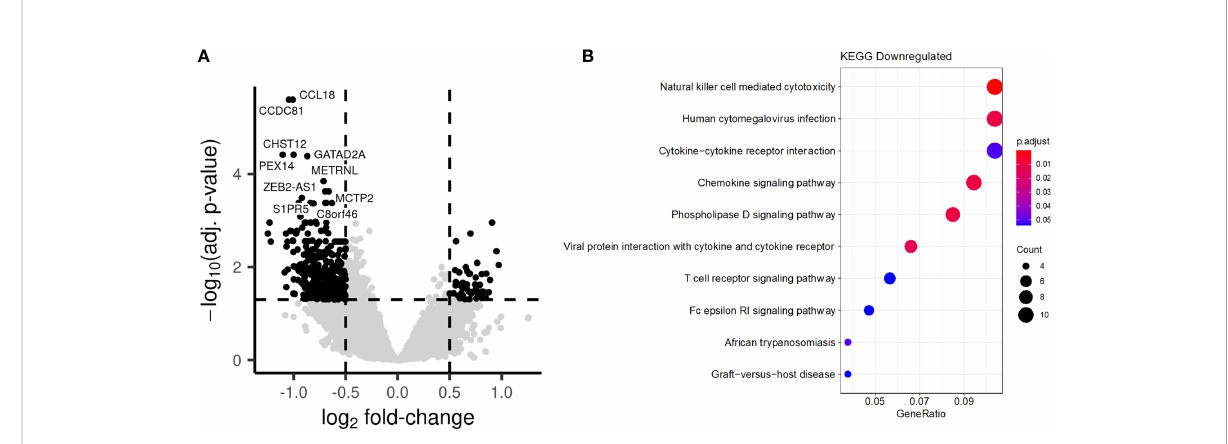
FIGURE 9 BCG vaccination induces long-term changes in chromatin accessibility. PBMCs were collected from individuals before and after BCG vaccination. (A) Comparison of the chromatin accessibility after BCG vaccination to before BCG vaccination. Each point represents a peak. Black points are signi fi cantly differentially accessible peaks (FDR<0.05 and absolute log-fold change > 0.5), while grey points do not differ Peaks are labelled by their closest gene by HOMER. (B) Barplot showing the most signi fi cantly enriched KEGG pathways after BCG. Genes linked to signi fi cantly differentially accessible peaks were considered to calculate the